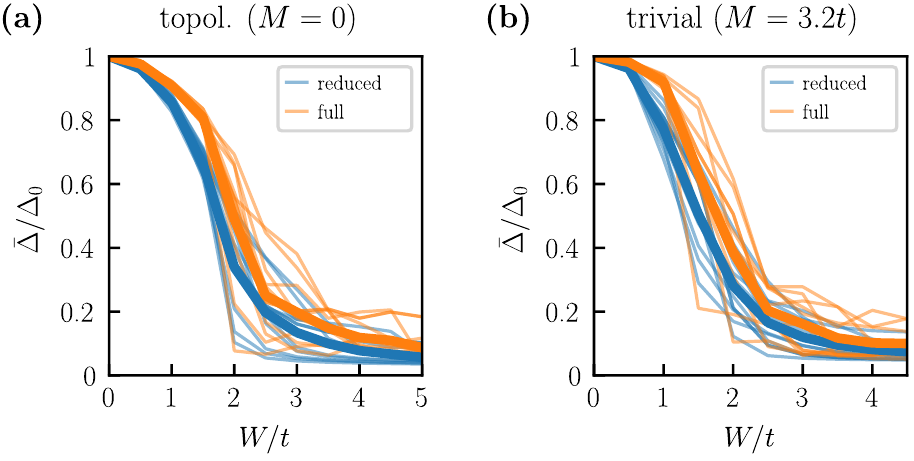
Figure 10: Comparison between full (orange) and reduced (blue) mean-field ap- proach for the superconducting order parameter ∆ in the extended Kane-Mele model / 100, and ¯ ν = 1 / 2: (a) topological phase and (b) trivial phase. with U = 3 t , T = T c ,0 We show results of single disorder realizations (thin lines) and their ensemble aver- ages (bold